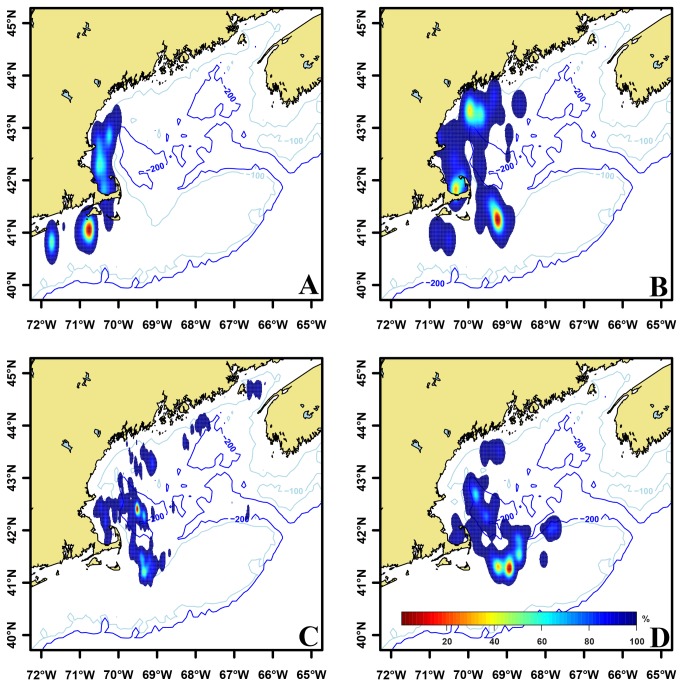
Distribution of Atlantic bluefin tuna in the Gulf of Maine.Kernel density estimations were constructed based on the number of fish observed in each school over four selected time periods. Density estimations were normalized yielding utilization distributions that displayed probability of occurrence during four time periods, A) 1979-1985, B) 1986-1992, C) 1993-1999, and D) 2000-2005.